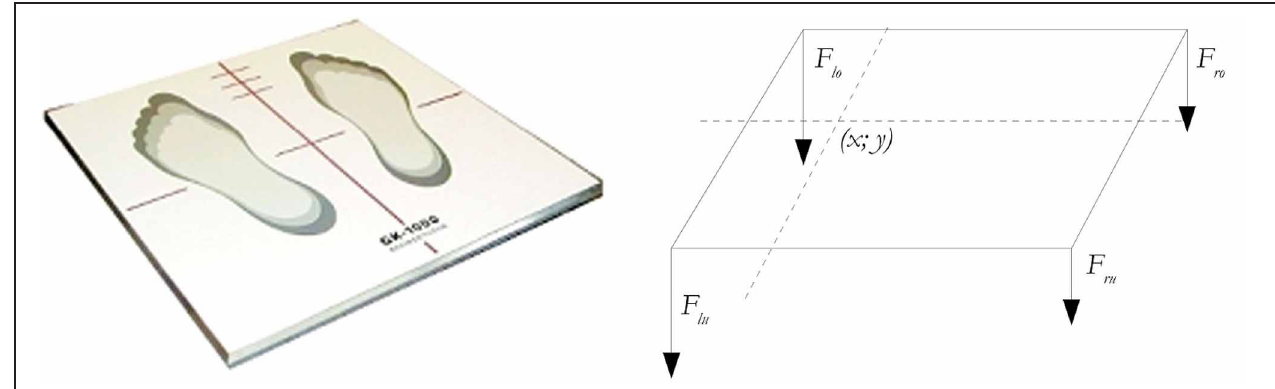
FIGURE 1 | The static posturography platform (GK-1000) is a computerized coordination and balance analysis system. With the help of four piezoelectric power sensors, the position and movement of the projection of the center of gravity can be measured and tracked.